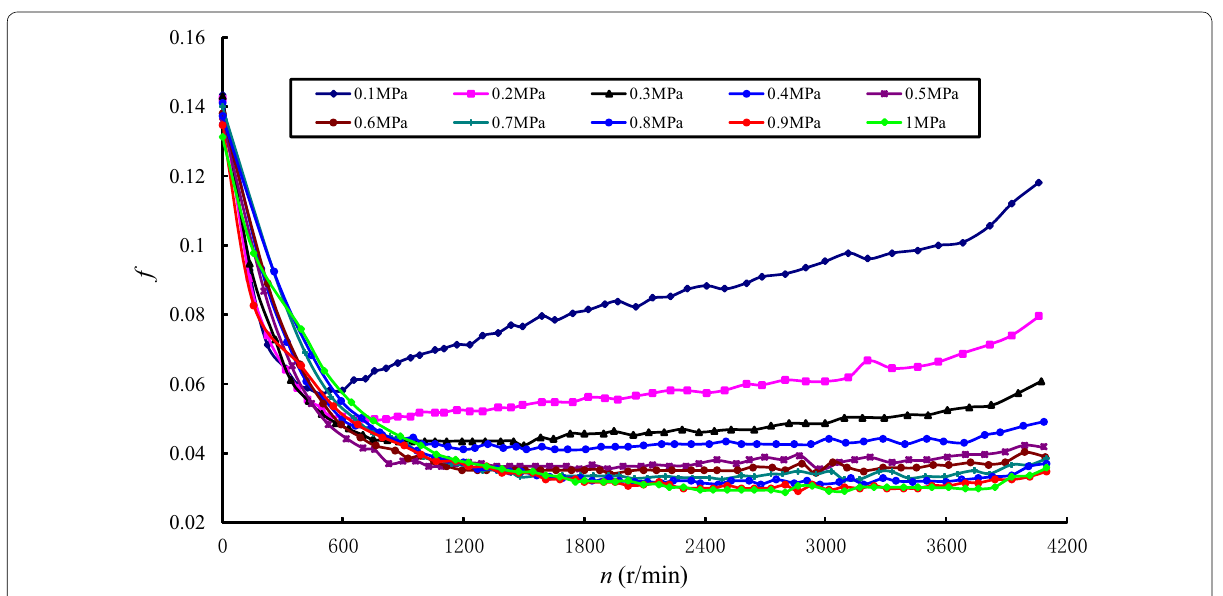
Figure 5 Variation of frictional coefficient with relative speed under different pressure